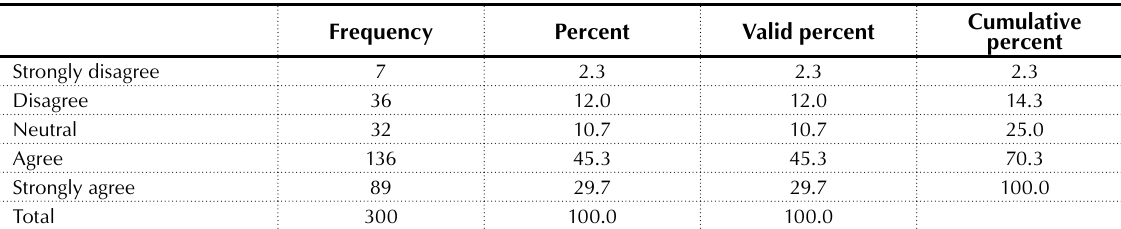
Table 2. CSC personnel took all needs into consideration in terms of service delivery